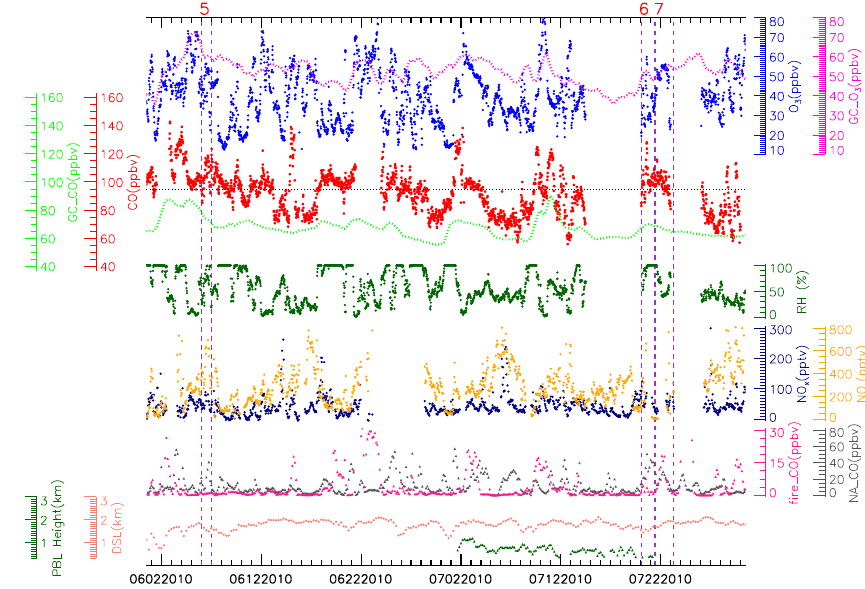
Fig. 2. Same as Fig. 1 but for summer